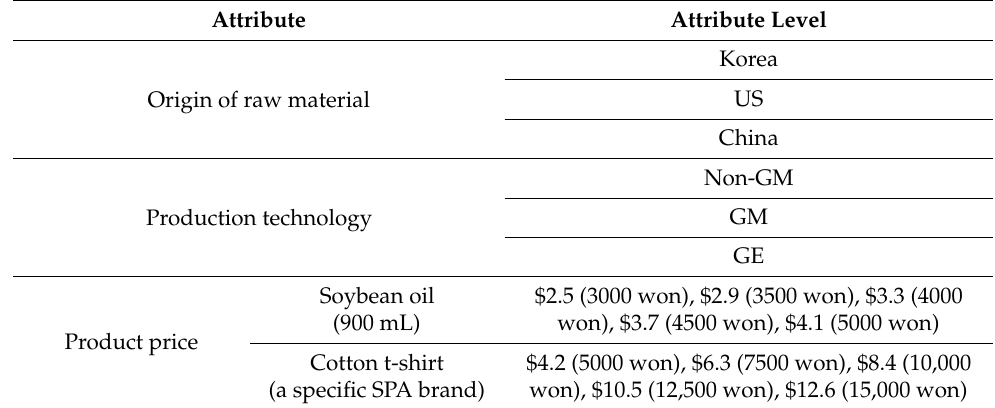
Table 3. An attribute and an attribute